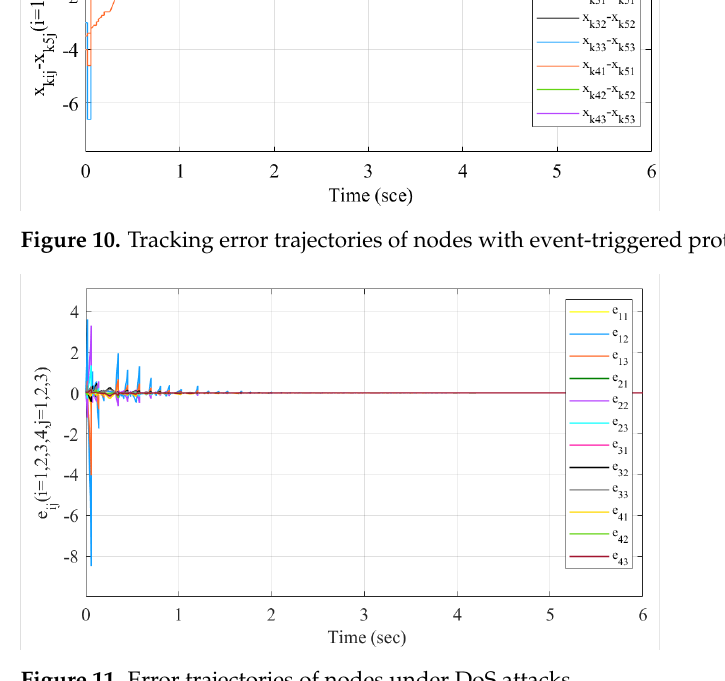
Figure 11. Error trajectories of nodes under DoS